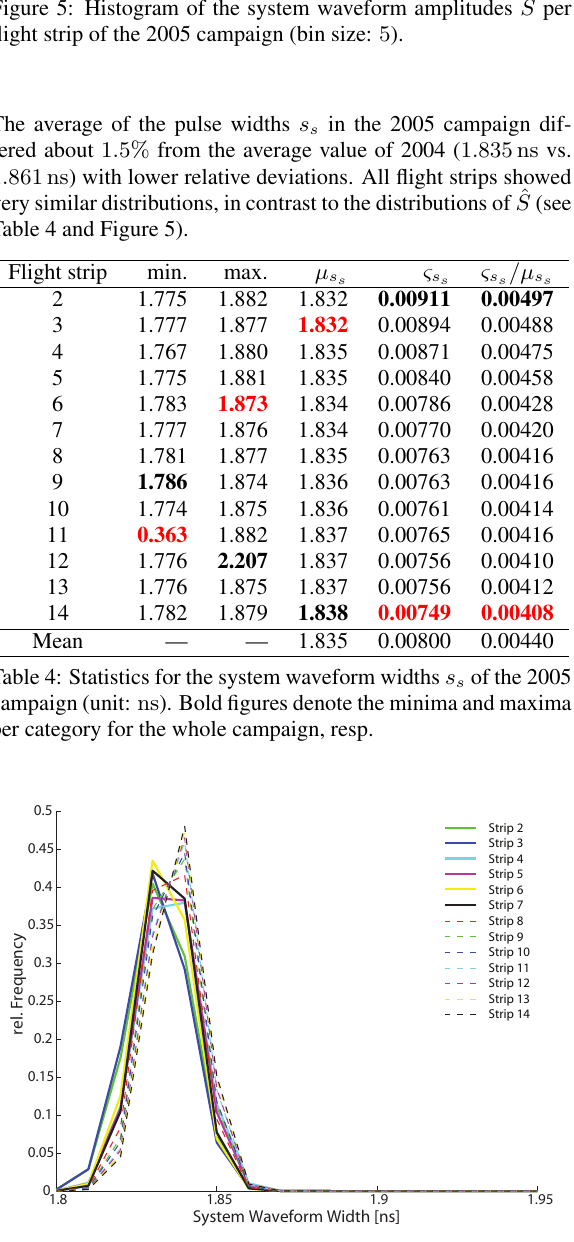
Table 5: Histogram of the system waveform widths s s per flight strip of the 2005 campaign (bin size: 0 . 01